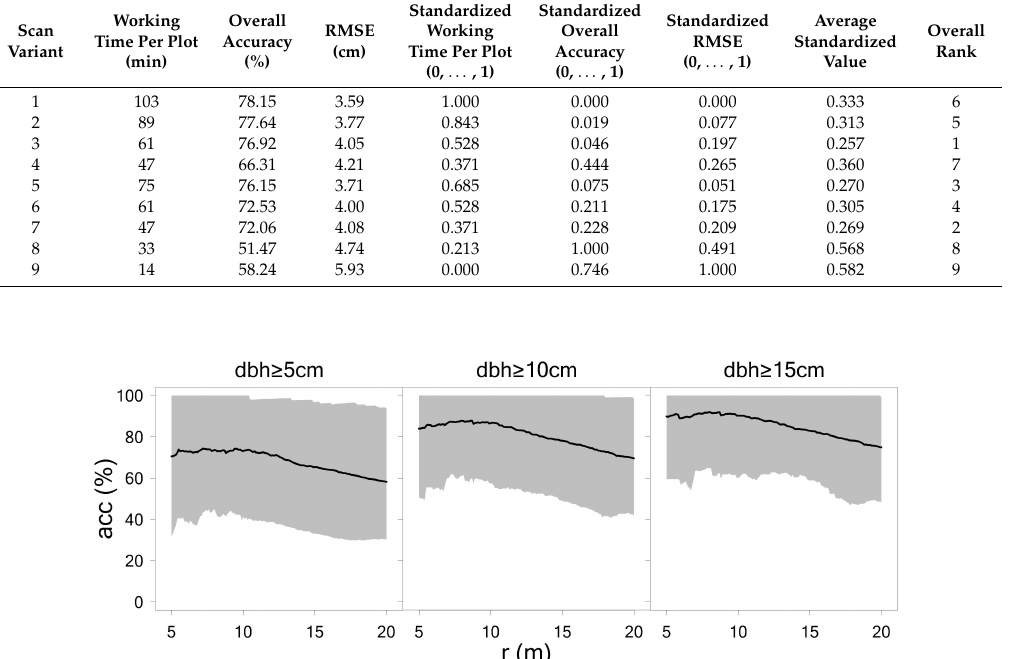
Table 5. Ranking of scan variants.